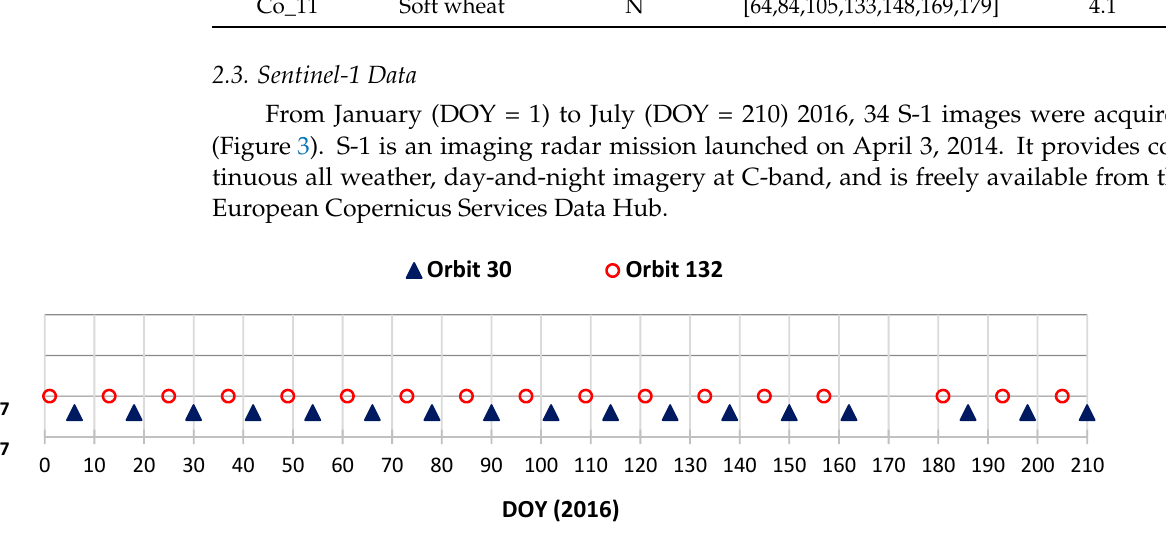
Figure 3. Time course of S-1 (orbit 30 and 132) acquisition from January to July 2016. Table 3. Main characteristics of Sentinel-1A images.